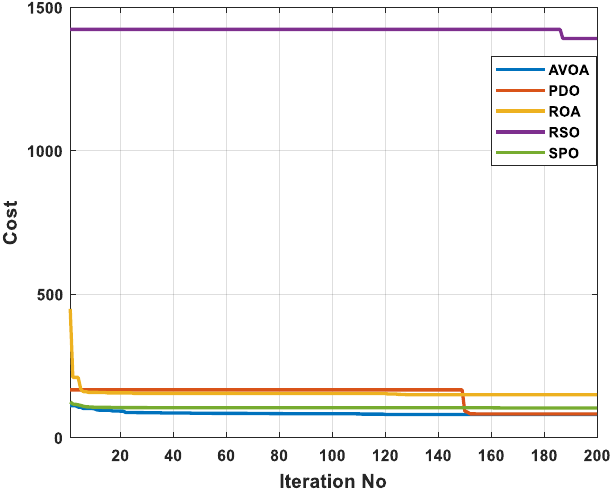
Figure 5. The AVOA convergence characteristics with the other compared methods for case 2. Table 9. Optimal IEEE 30-bus test system control variables for lessening operational